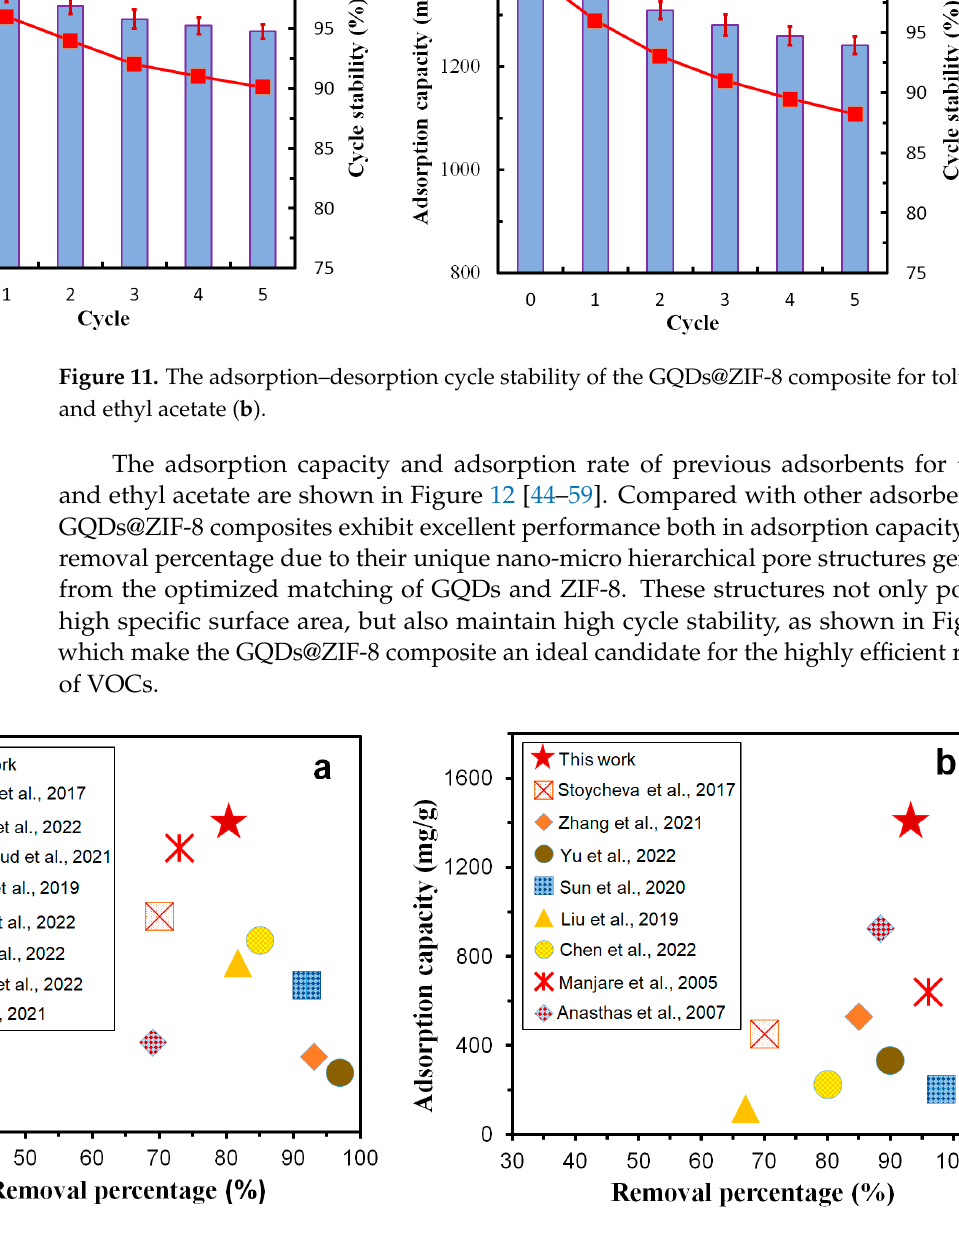
Figure 12. Comparison between previous works and this work on the adsorption properties of GQDs@ZIF-8 composites for toluene ( a ) [44 – 51] and ethyl acetate ( b ) [52 – 59]. GQDs@ZIF-8 composites for toluene ( a ) [44–51] and ethyl acetate ( b )